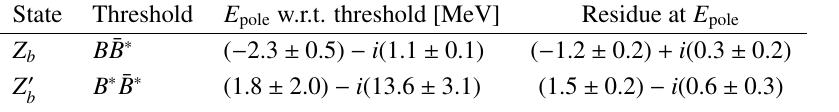
Table 1. The pole positions E R and the residues g 2 in various S -wave B ( ∗ ) ¯ B ∗ channels for the most advanced pionful fit [10]. The energy E R is given relative to the nearest open-bottom threshold quoted in the second column. Uncertainties correspond to a 1 σ deviation in the parameters allowed by the fit to the data in the channels with J PC = 1 + − where the Z ( (cid:48) ) states reside. The theoretical uncertainty from b the truncation of the EFT expansion was estimated for these states to be about 1 MeV [10].